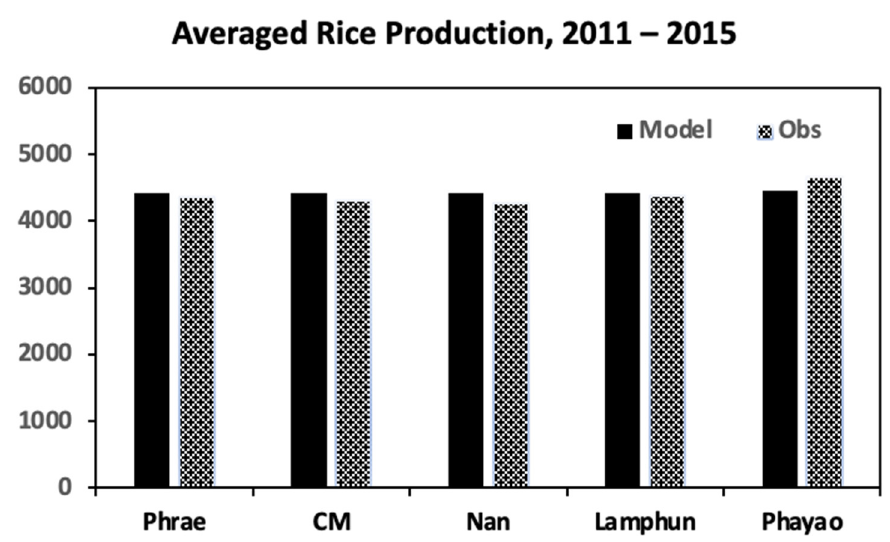
Figure 5. Average total rice production over 2011–2015 based on location in Figure 2 between the DSSAT model (black) and information from the Department of Agriculture. Table 3. Statistics comparing the model and observations.